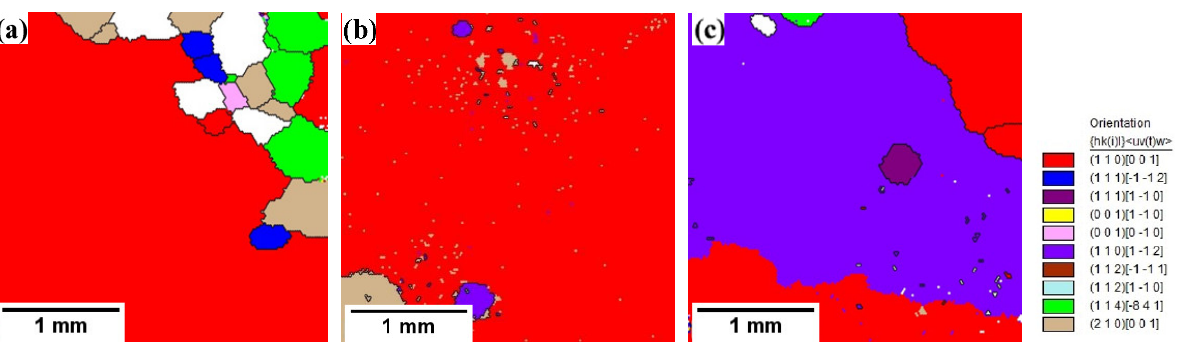
Figure 5. EBSD orientation maps of finally annealed samples in different atmospheres: ( a ) 100%H 2 ; ( b ) 25%H 2 + 75%N 2 ; ( c ) 50%N 2 + 50%H 2 .